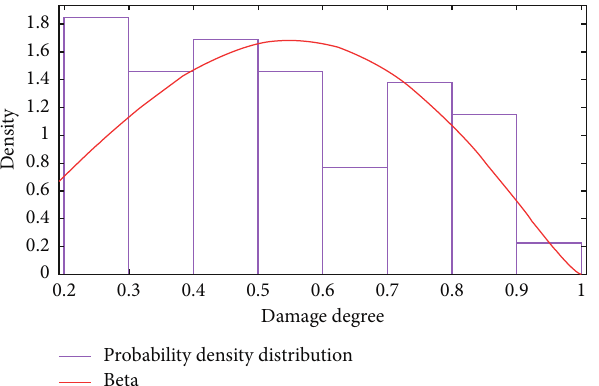
Figure 13: The probability density histogram and fitting curve of damage degree by shaped